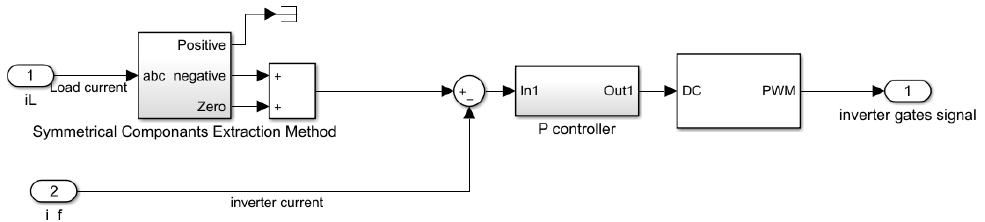
Figure 2. Modified control block diagram.